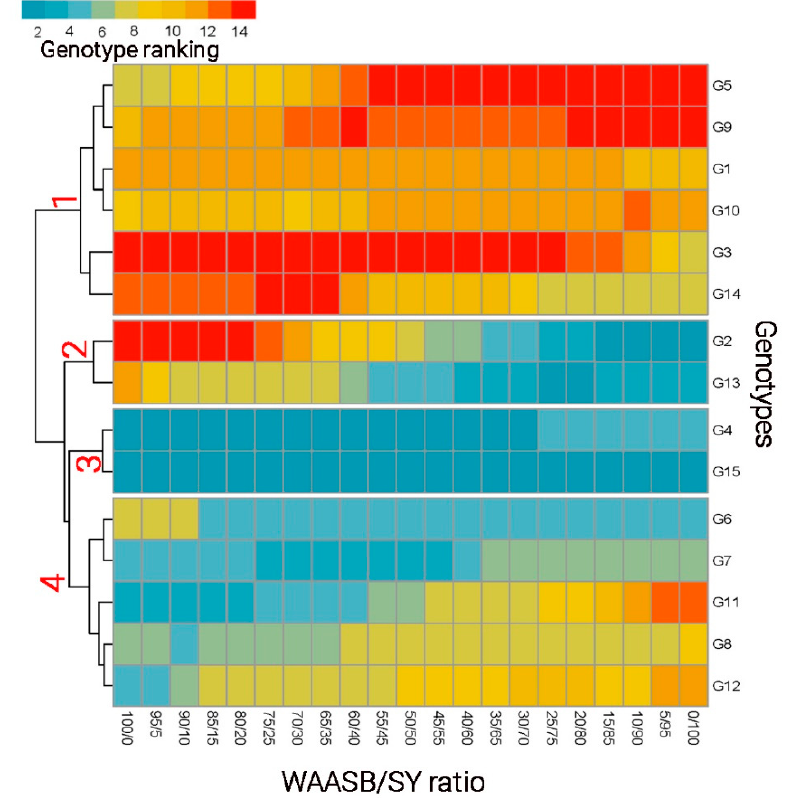
Figure 5. The ranking of 15 landraces of faba bean based on various WAASB and SY evaluated over three growing seasons. Values from 1 to 15 represent the different landraces (see Table 1 for more details). Red values from 1 to 4 represent the different clusters.